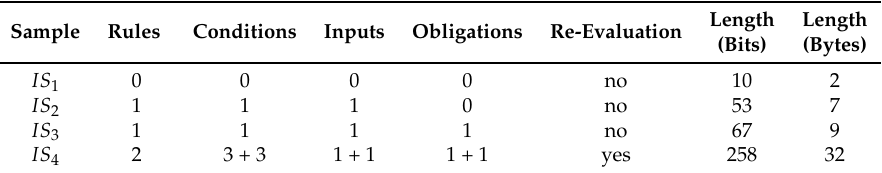
Table 3. Examples of policy instance samples.